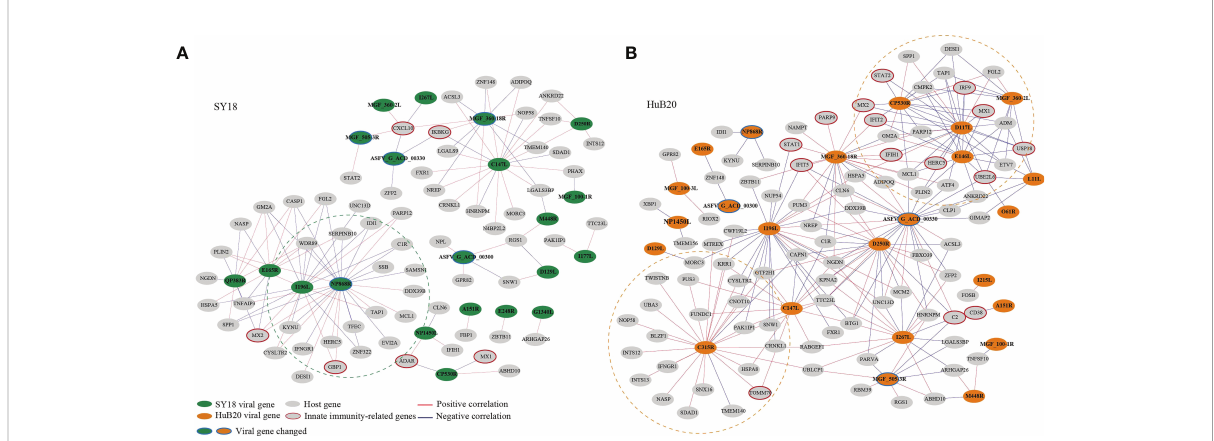
FIGURE 7 The correlation between the ASFV and host DEGs was measured using Pearson correlation coef fi cients for the corresponding gene expression and is visualized in the network for SY18 (A) and HuB20 (B) strains. The absolute value of the Pearson correlation coef fi cient > 0.9 was considered signi fi cant. Red and blue lines indicate positive and negative correlations,